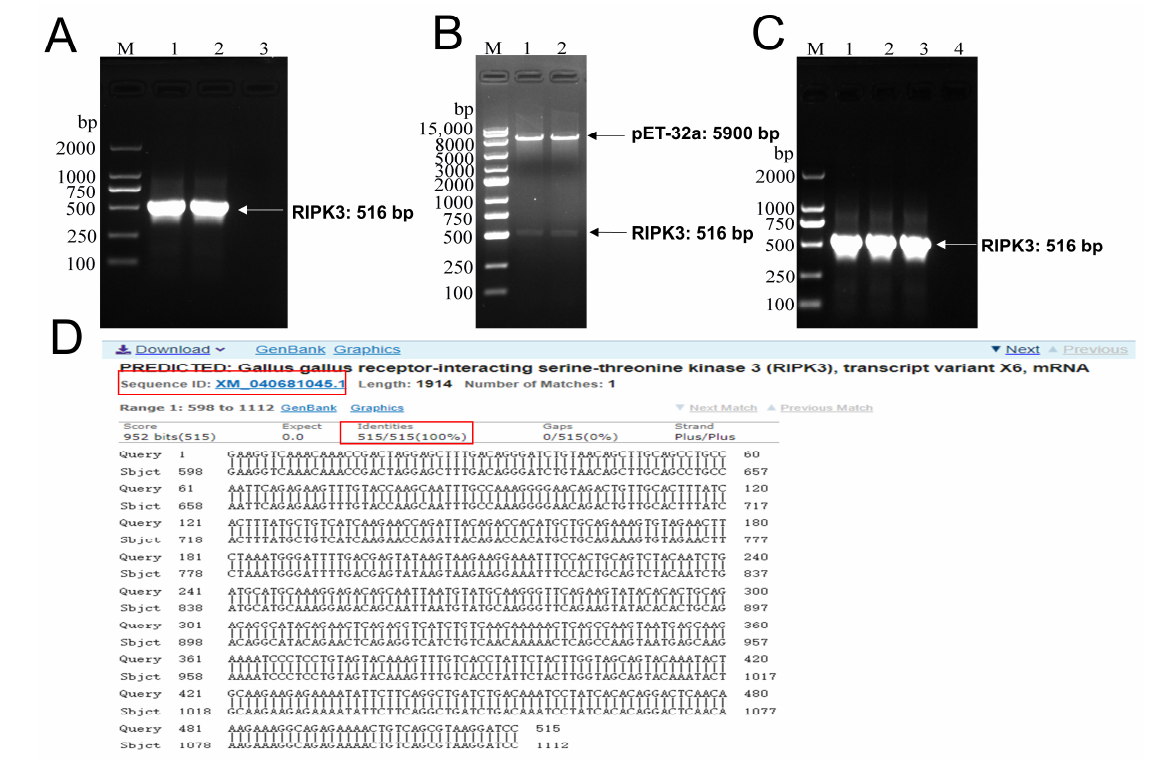
Figure 1. Construction of pET-32a-RIPK3 prokaryotic expression vector. ( A ) The coding sequence of the RIPK3 truncated protein gene was successfully obtained via PCR amplification; lane 1–2: RIPK3 gene (516 bp) was amplified at 56 ◦ C; lane 3: negative control. ( B ) RIPK3 truncated protein gene was successfully inserted into the pET-32a (+) vector as confirmed by double-restriction digestion identification; lane 1–2: recombinant pET-32a-RIPK3 after double-enzyme digestion. ( C ) Colony PCR; lane 1–3: PCR products of RIPK3 truncated protein gene in bacterial liquid; lane 4: negative control. ( D ) Sequencing results of recombinant plasmids transferred into BL21 receptor cells.